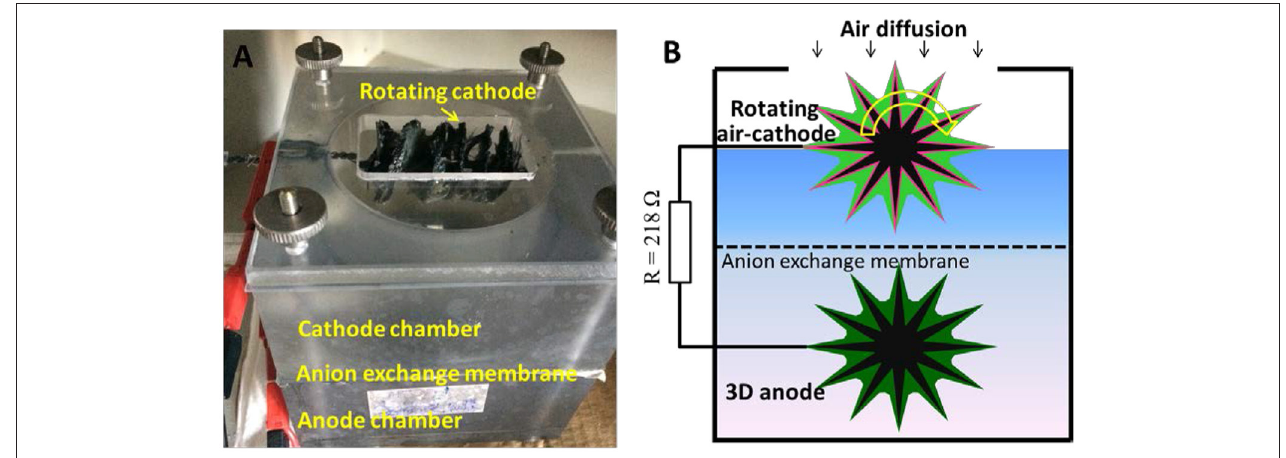
FIGURE 1 | (A) Digital picture and (B) schematic diagram of the MFC set-up used for the development of bio-GB/NPC-AC and subsequent substrate crossover